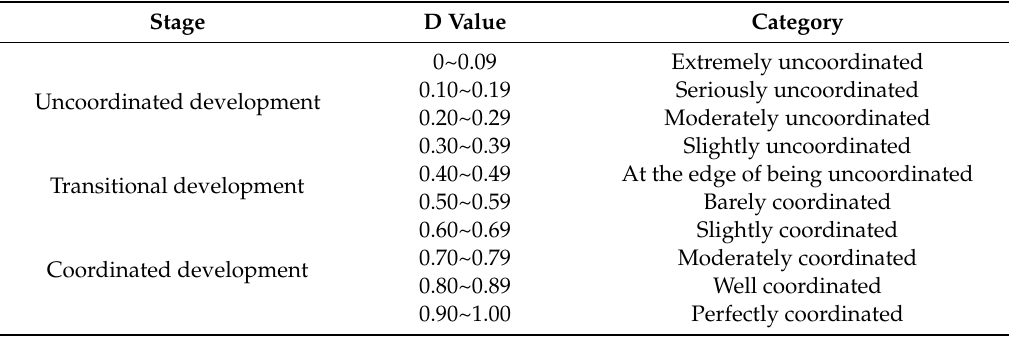
Table 2. Discriminating standards of the coupling coordination